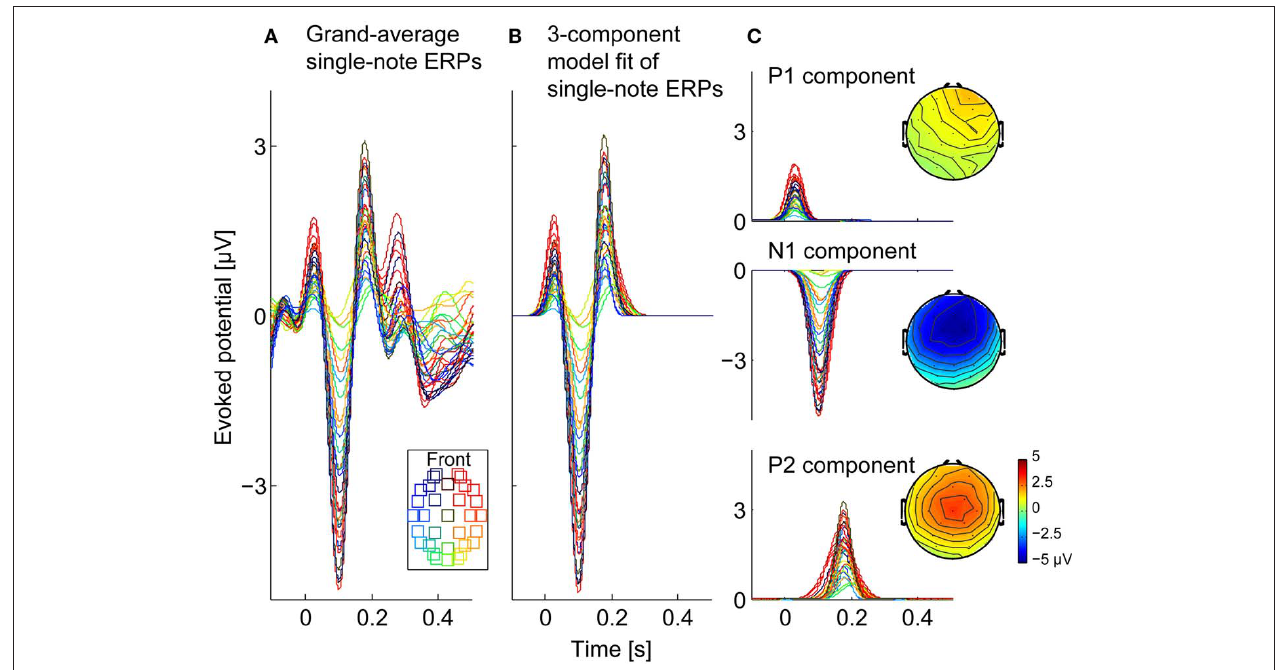
FIGURE 3 | Observed and modeled single-note ERPs. (A) Observed single-note ERPs, averaged across three subjects (714 trials in total). Each trace shows responses from one of the 32 channels (see legend for electrode locations). (B) Three-component model of the single-note ERPs,